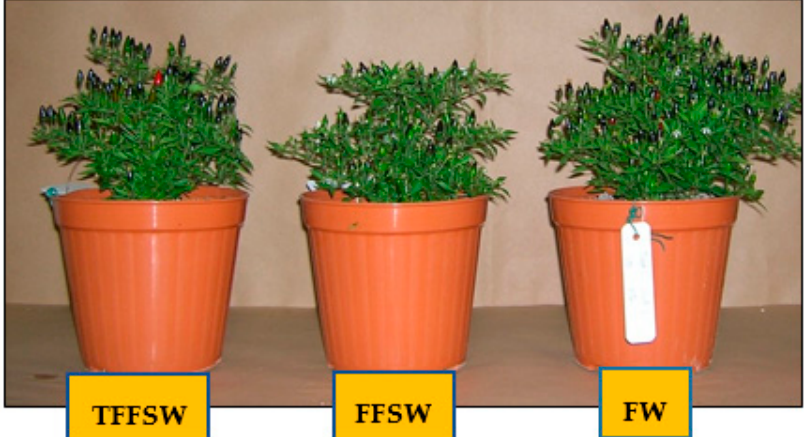
Figure 9. A view of the effect of source of irrigation water on the morphological and aesthetic parameters of ornamental pepper plants.